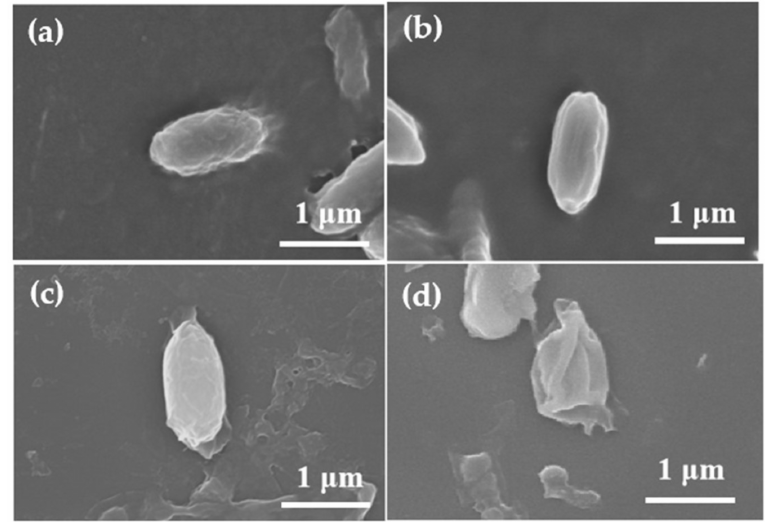
Figure 6. SEM images of B. subtilis spore treated by the Vis/NS/PS system with different irradiation time (Magnification: 20,000 × ). ( a ) 0 h, ( b ) 2 h, ( c ) 4 h, ( d ) 5 h.